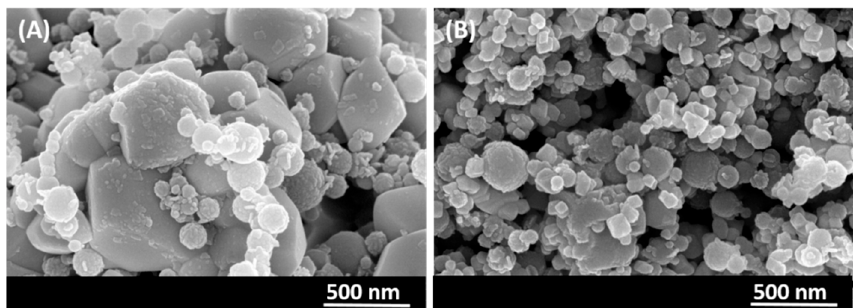
Figure 1. SEM images of the ( A ) Al/In 2 O 3 _µm and ( B ) Al/In 2 O 3 _nm energetic formulations, respectively.